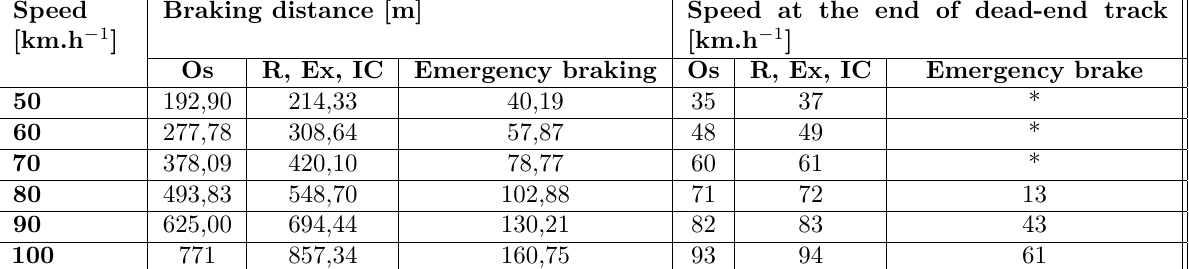
Table 4. Deceleration of trains